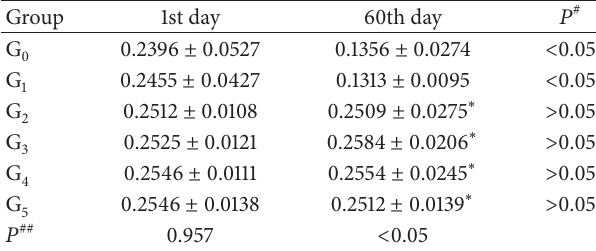
Table 2: Bone densities surrounding the bone-bone cement inter- faces (g/cm 2 ) on the 1st day and 60th day after surgery in each